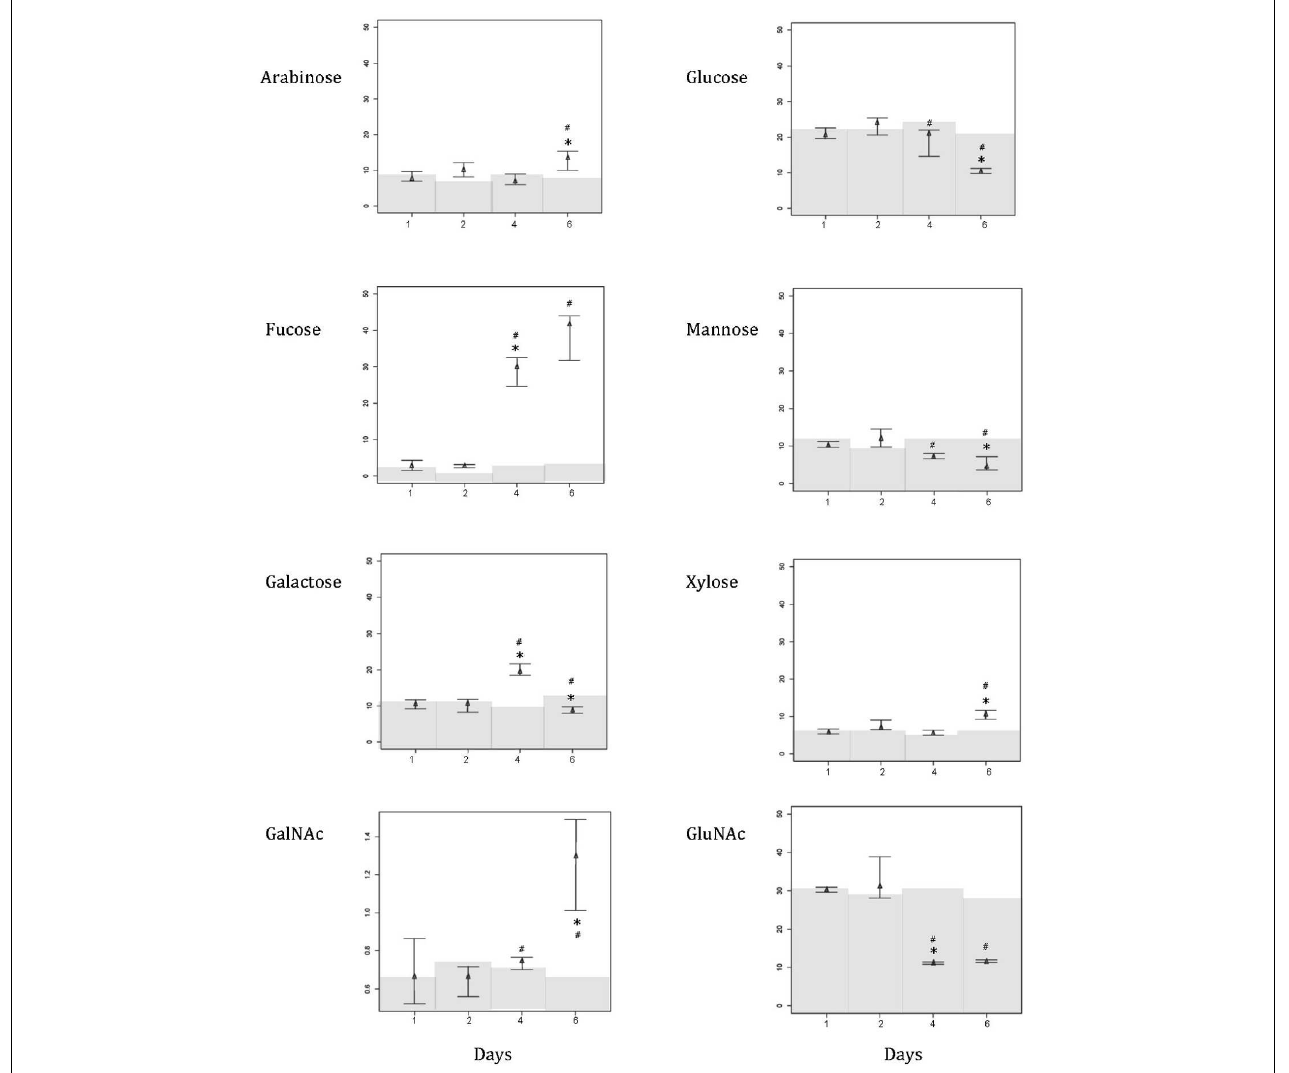
FIGURE 2 | Composition shift (in percentage) of various sugar in the mucus layer of Acropora muricata from day 1 to day 6. Water temperature started at 26 ◦ C on day 1, and was increased 1 ◦ C from 26 to 31 ◦ C. Temperature in control tank was constant at 26 ◦ C. Note that the scale for GalNAc is different from the rest of the sugars in order to show the changing trend. Gray regions represent the relative composition of the various sugar in the control samples. ∗ Represents significant difference between treatment tanks, and # represents significant difference between control and treatment tanks at 0.05.